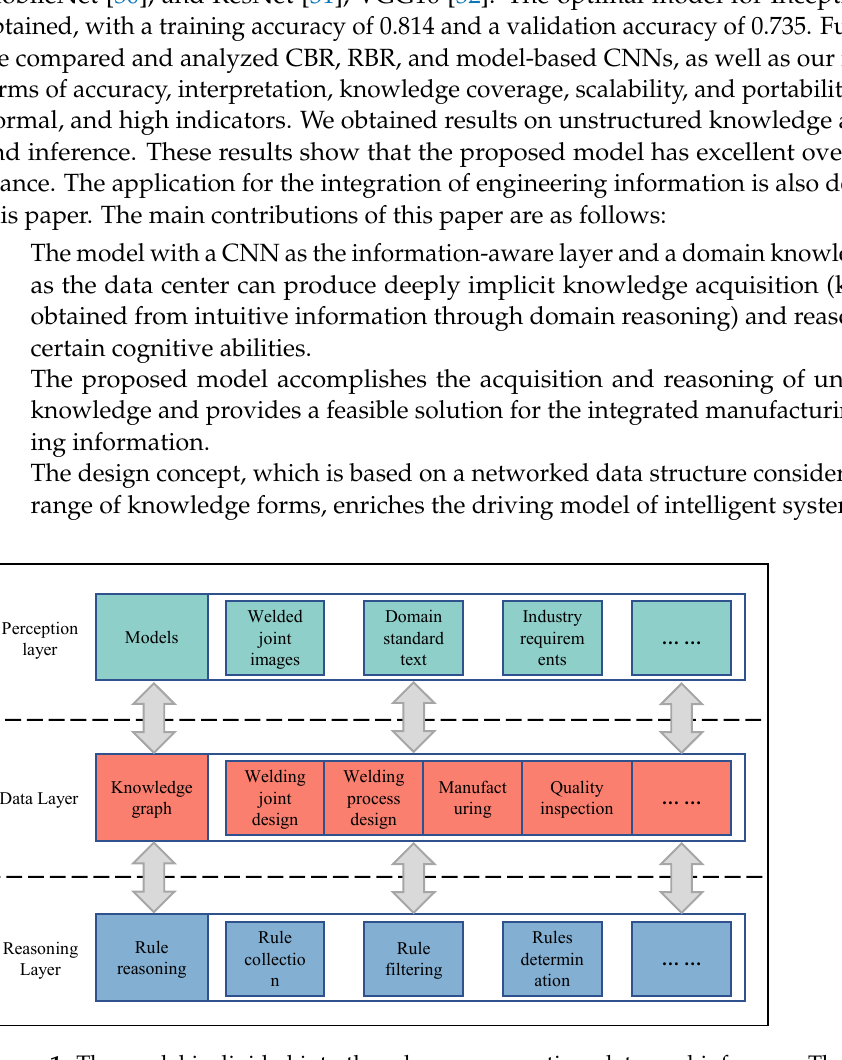
Figure 1. The model is divided into three layers: perception, data, and inference. The perceptual layer is based on intelligent perception models (CNN is employed as the perception layer model in this study). The data layer is based on knowledge graphs, while the inference layer is based on rule-based reasoning.